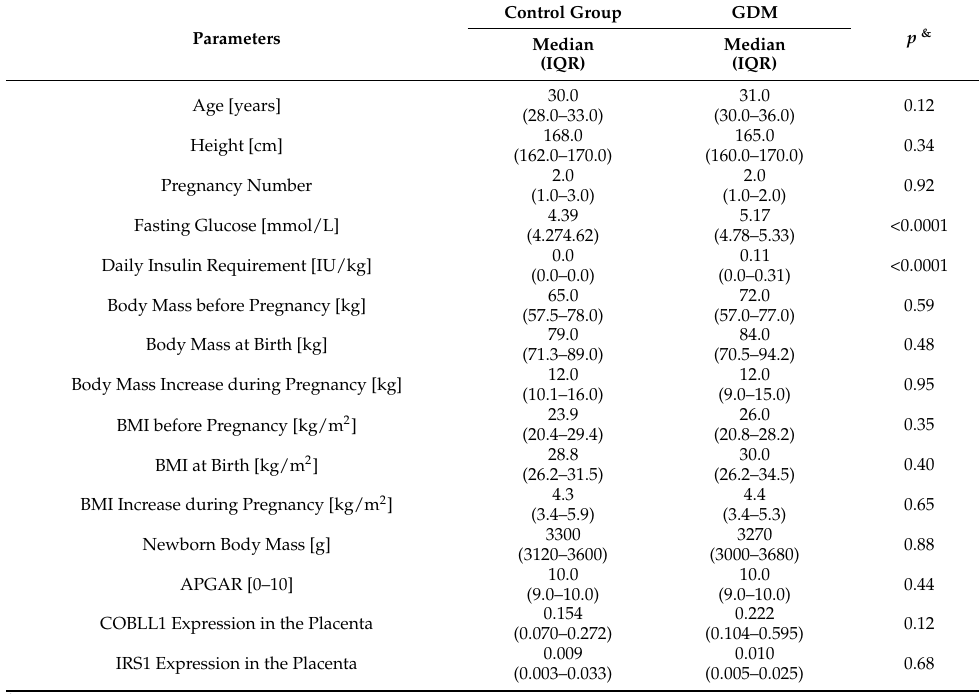
Table A2. Clinical characteristics of women included in the analysis of placental expression of COBLL1 and IRS1